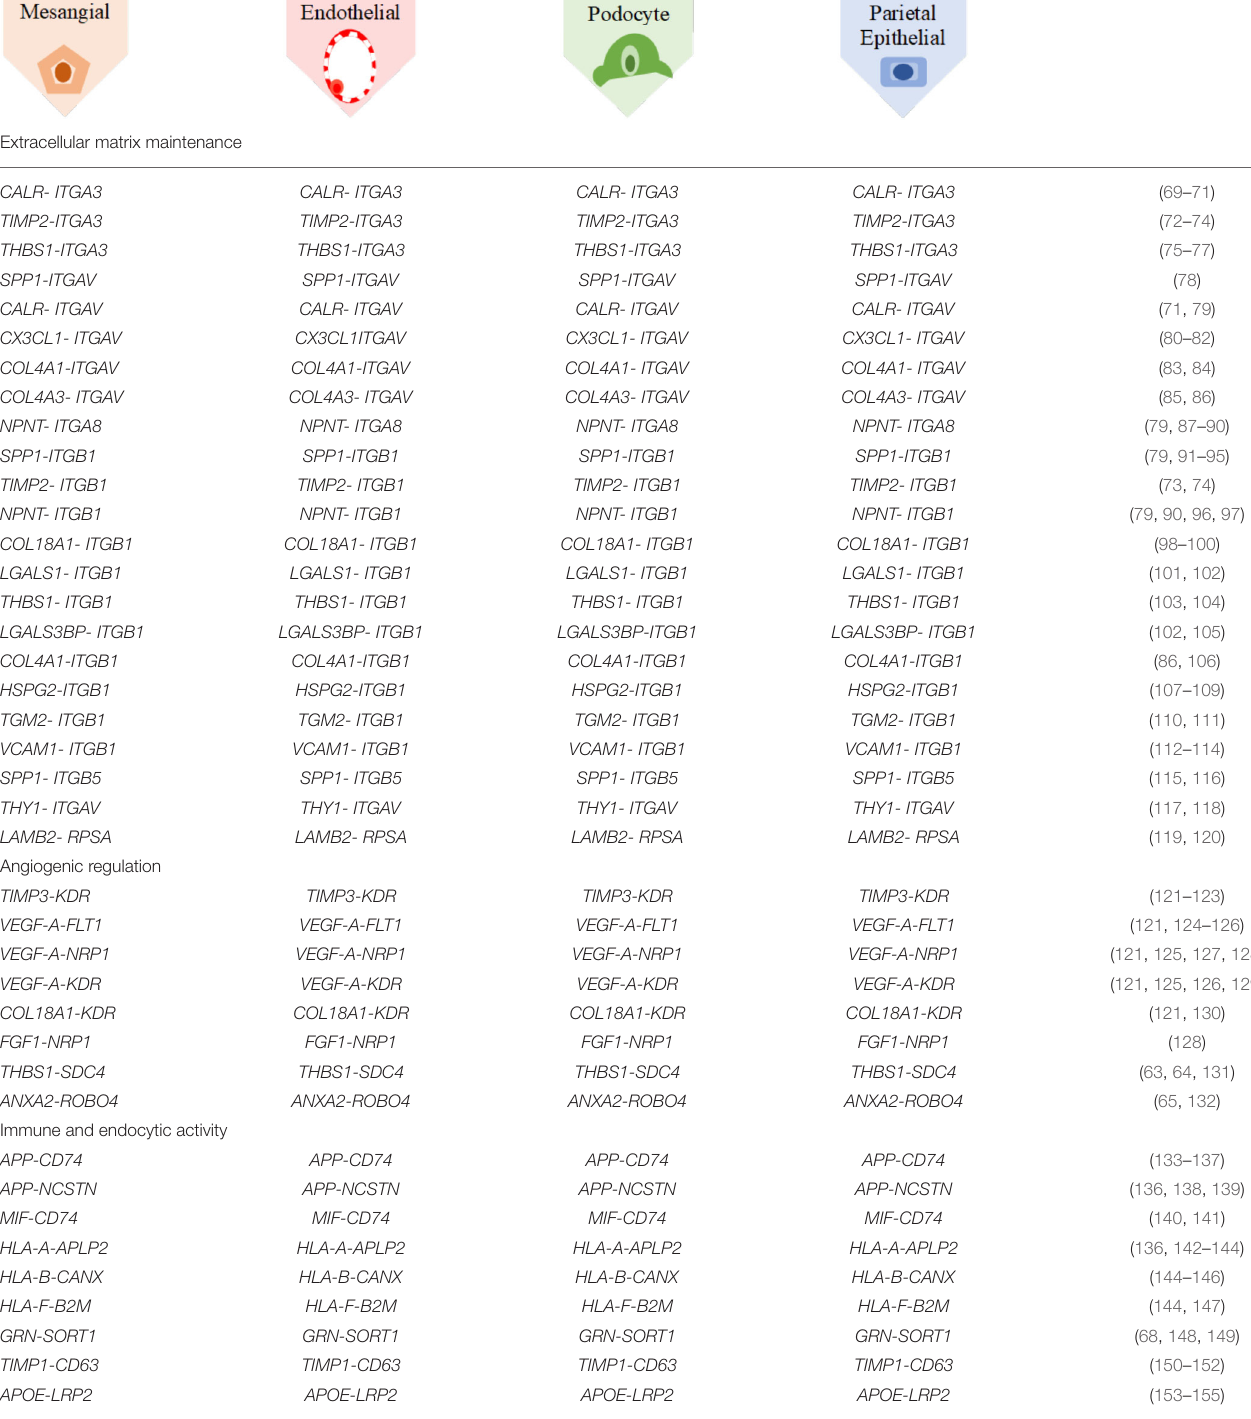
Key, L-R presence indicated by back text and absence indicated by the gray text. The literature-based locations of the top 40 glomerular L–R gene pairs were confirmed in sc/snRNA-seq datasets, as an expression within glomerular cell types. In particular